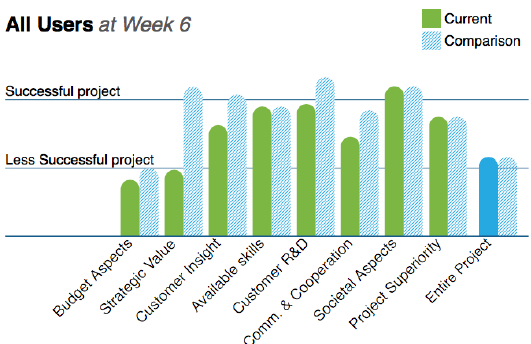
Fig. 2. Building block for comparison of projects, comparison of performance in time, or comparison of different team-members’ input in a project at a certain point in time. In this example, the combined score of all users in week 6 of the project is compared to a random other project